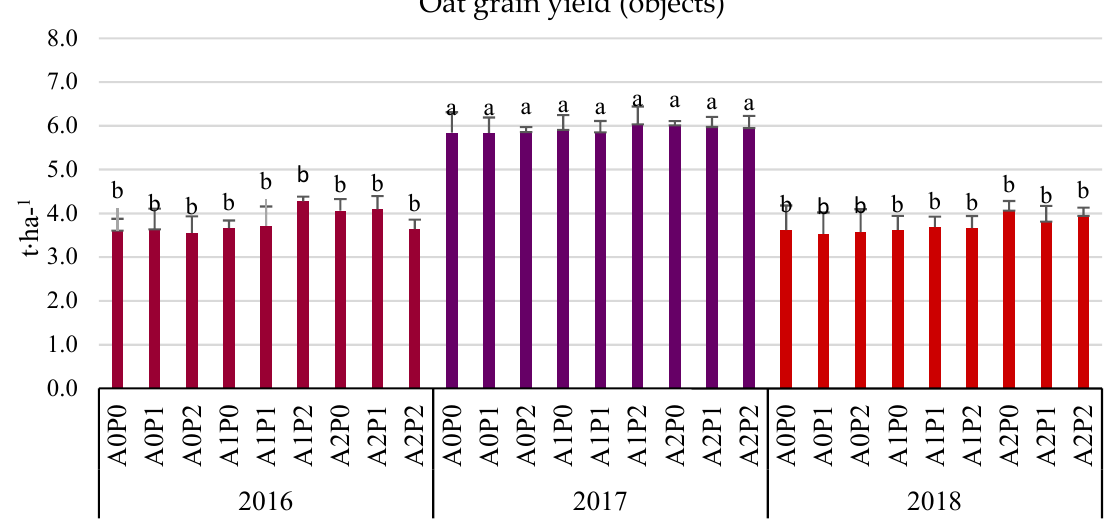
Figure 8. Average oat grain yield depending on the combination of algae application and magnetic field stimulation in 2016–2018. A (algae) and S (magnetic stimulation), factors of experience; factor levels 1, 2, and 3; A0S0, control. According to Tukey’s HSD (honest significant difference) test, the means marked with the same letter were not significantly different at α ≤ 0.05.